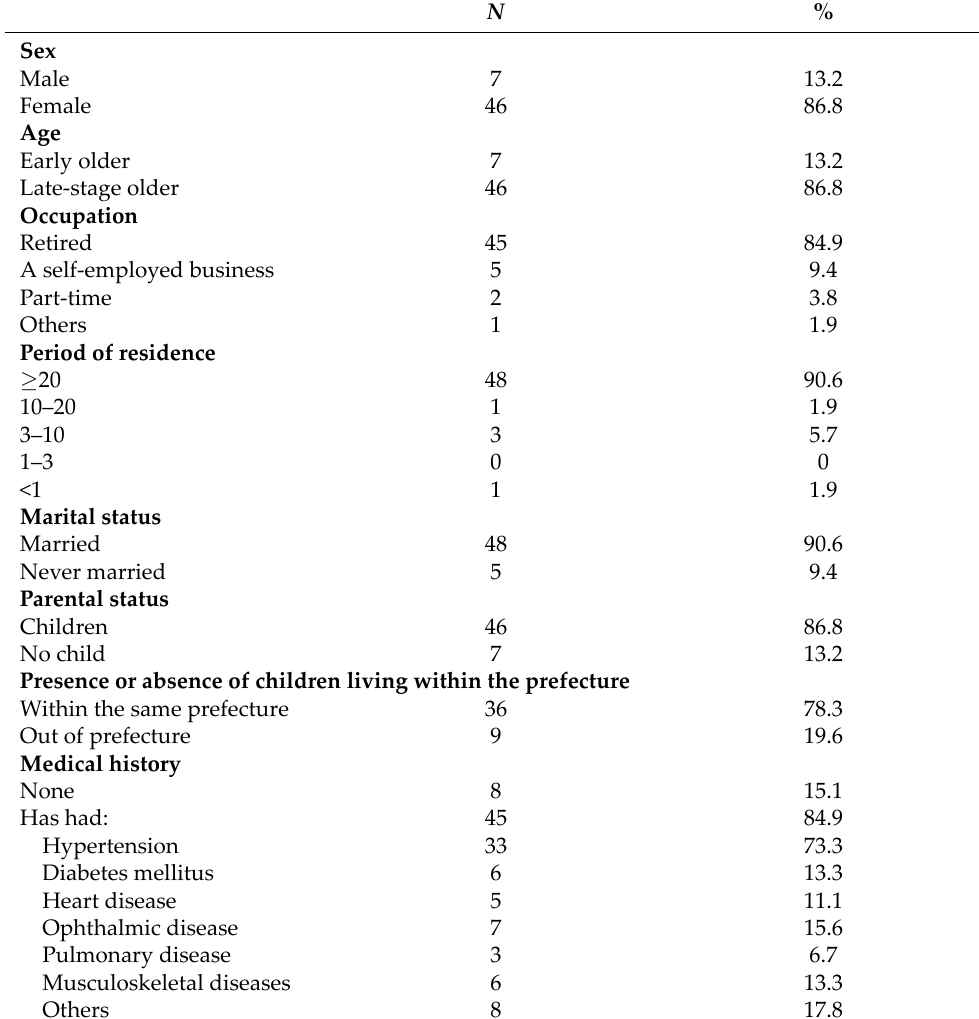
Table 2. Characteristics of participants ( n =